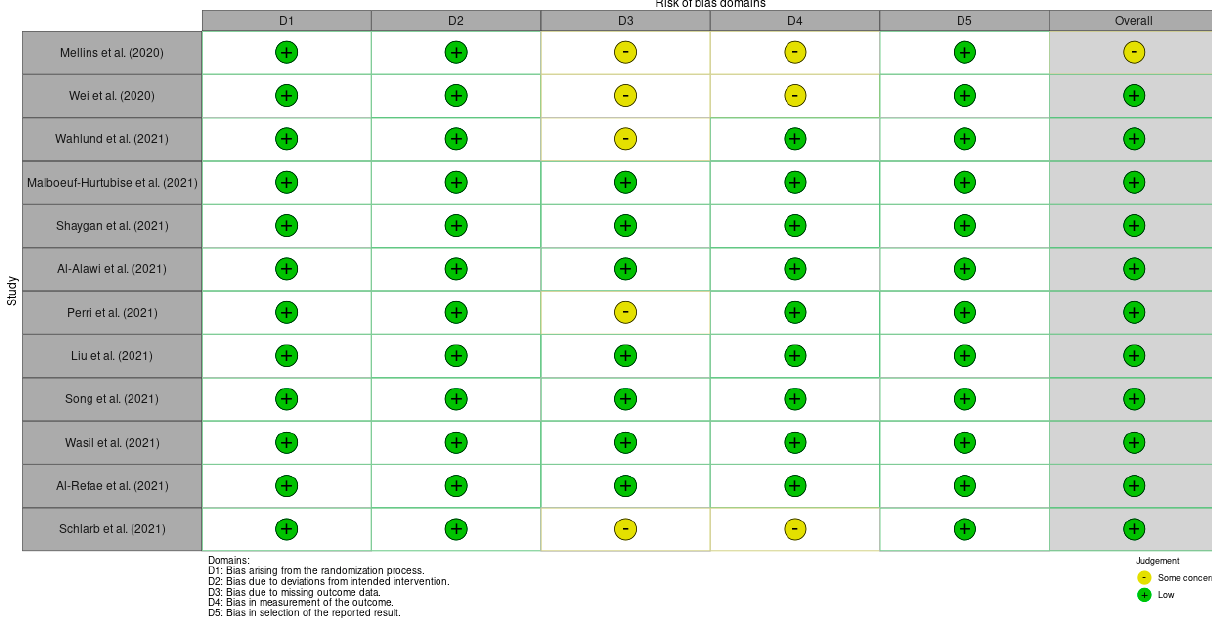
Figure 1. Flow diagram outlining the selection procedure to identify articles which were included in the analysis of psychological interventions in SARS-CoV-2 pandemic emergency.